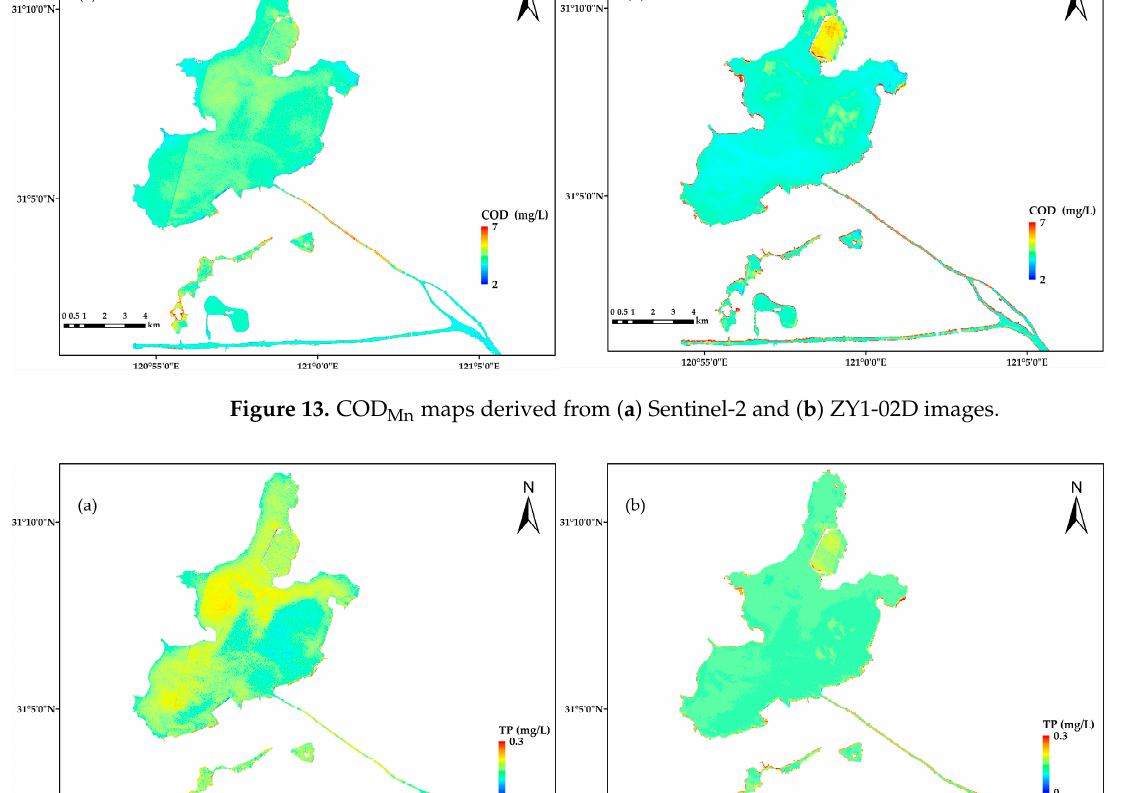
The range of the color bar was retained consistently for a better comparison.